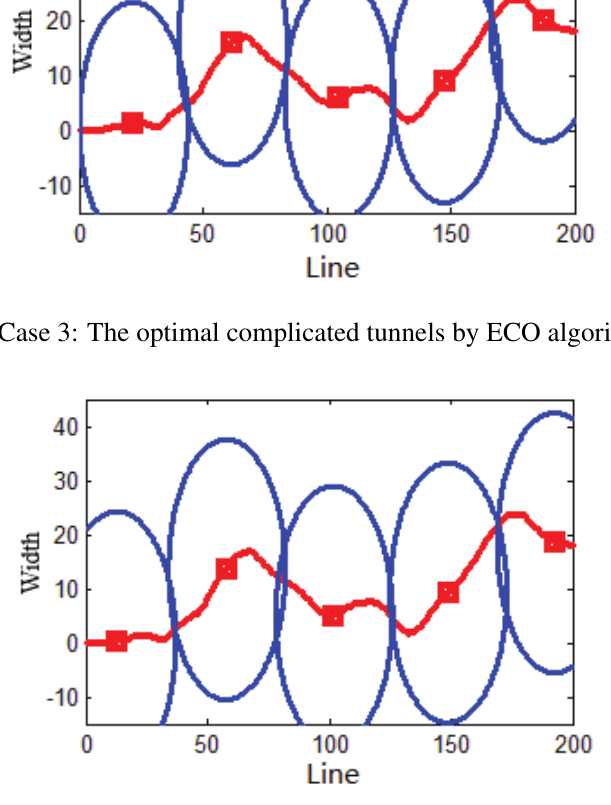
Figure 18: Case 3: The optimal complicated tunnels by ECO algorithm (R =